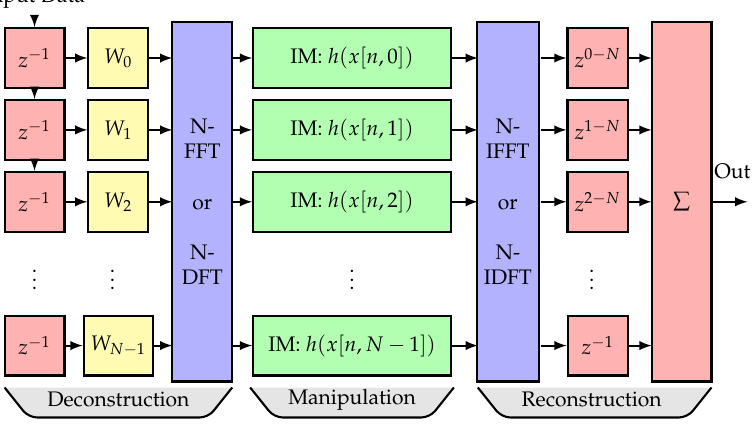
Figure 1. HDDM block diagram. ©IEEE. Reprinted, with permission, from